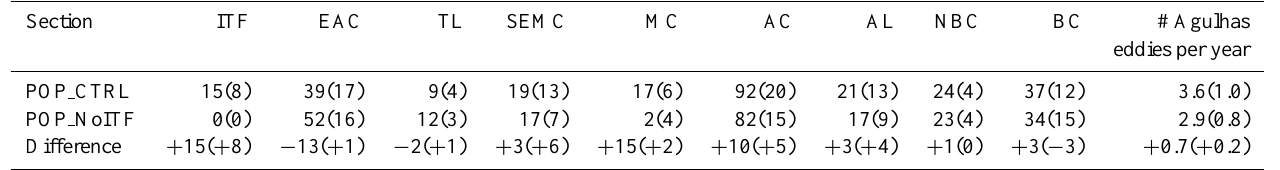
Table 2. Mean transport (in Sv) across different sections of POP CTRL and POP NoITF rounded to integer values. The standard deviation is given between brackets. Note that the numbers are rounded to